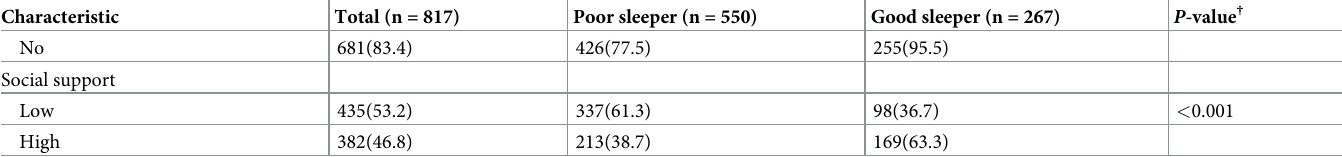
79 years (AOR: 1.78, 95% CI: 1.08, 2.92) or 80 years and above (AOR: 2.67, 95% CI: 1.68, 4.24) increased the risk of poor sleep quality when compared with age between 60 and 69 years after adjustments were made for other confounding factors. Moreover, participants with one to two kinds of chronic diseases (AOR: 2.05, 95% CI: 1.39, 3.01), three or more kinds of chronic dis-